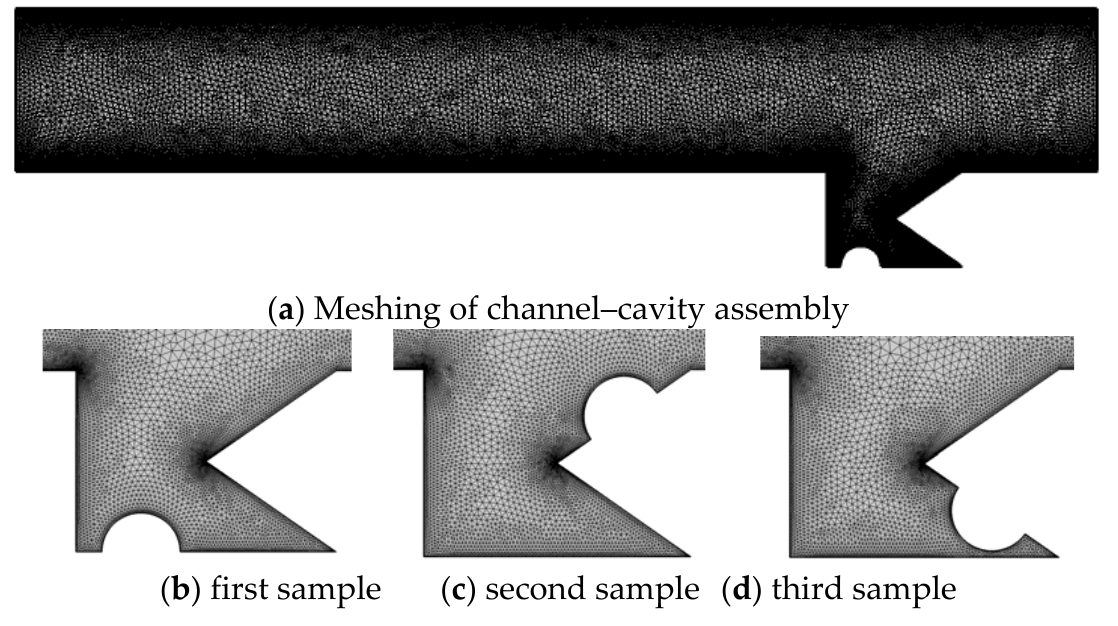
Figure 2 . Mesh generation . Figure 2. Mesh generation. Table 2. Test of grid independence for 0.1 m/s (Reynolds number = 2.8814) of intake air